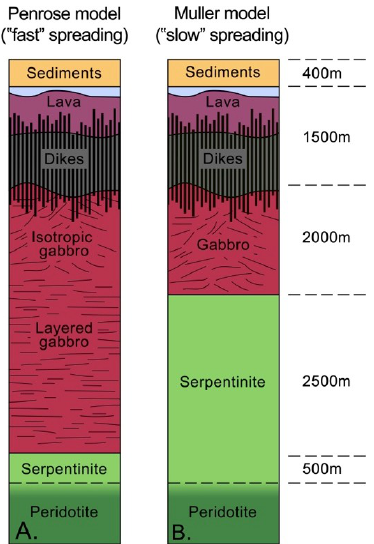
Figure 1. Simplified schematic diagram of representative cross sections of oceanic lithosphere produced at ( A ) fast- [17] and ( B ) slow- [21] spreading ridges. Serpentinite in the diagram represents either concentrated zones of serpentinization or diffuse serpentinization throughout the upper lithospheric mantle [24]. Oceanic lithosphere produced at slow- and ultraslow-spreading ridges is particularly heterogeneous, with serpentinites commonly outcropping on the ocean floor [20,22].